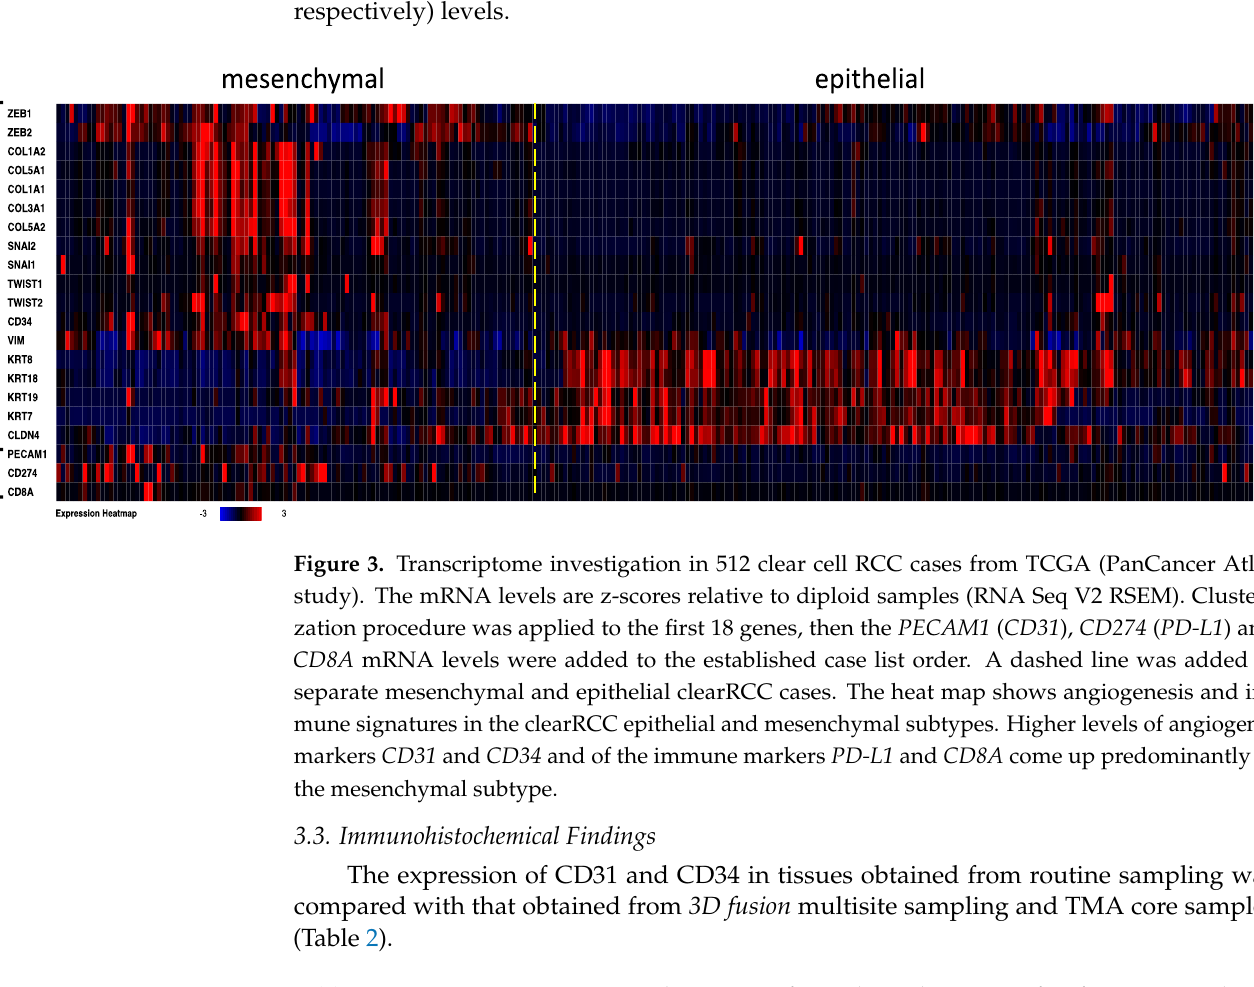
Table 2. Neoangiogenesis measured as count of vessels in clearRCCs after fusion 3D multisite sampling (tumor included in